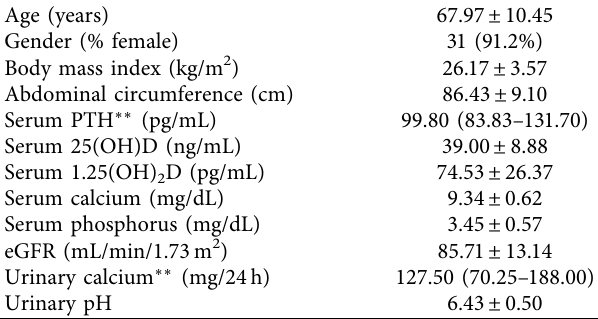
Table 1: General characteristics of the study